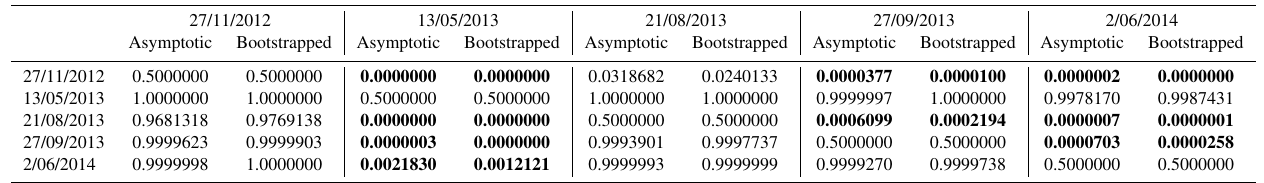
Figure 8. The water extents in the analysed sections in the ´Scinawka channel in Gorzuchów on 27 November 2012, 13 May 2013, 21 Au- gust 2013, 27 September 2013 and 2 June 2014. Numbers of the sites (on the left) are the same as in Fig. 3. Table 6. P values of asymptotic and bootstraped the Student’s t test applied to identify significant differences between water surface areas observed on 27 November 2012, 13 May 2013, 21 August 2013, 27 September 2013 and 2 June 2014. Bold values indicate statistically significant